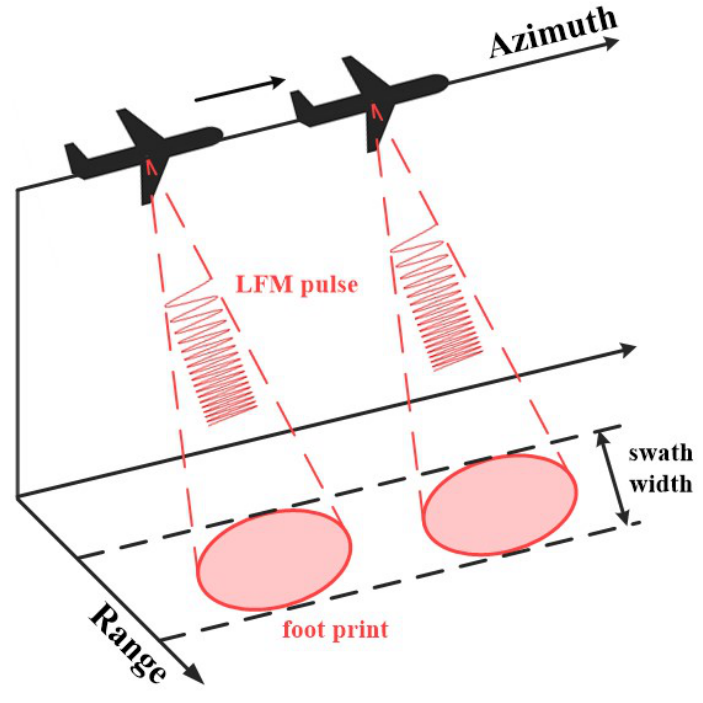
Figure 1. Illustration of the working principle of